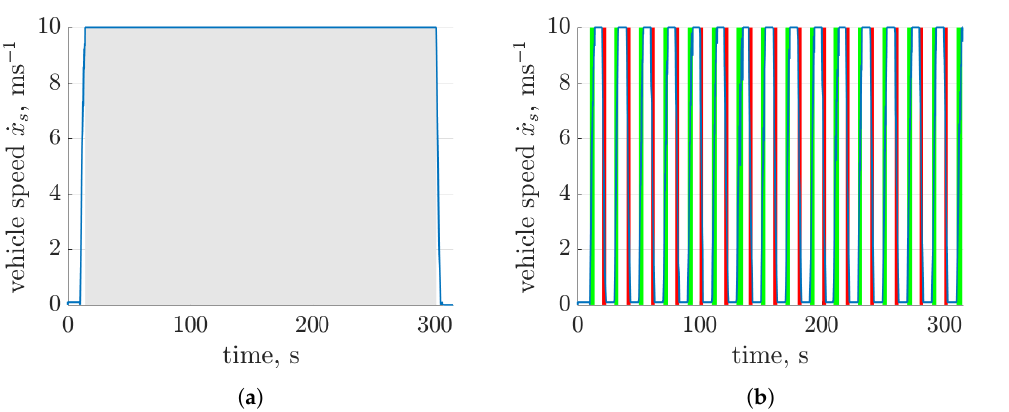
Figure 8. Procedure of simulation tests of the vehicle model: ( a ) constant vehicle speed, transmissibilities T , power spectral densities S and values of vehicle handling index J vh were evaluated for simulation data corresponding to the gray area, ( b ) multiple accelerating and braking phases, the values of road holding index J rh were evaluated for simulation data marked by the following areas: green for accelerating and the rear wheel, red for braking and the front